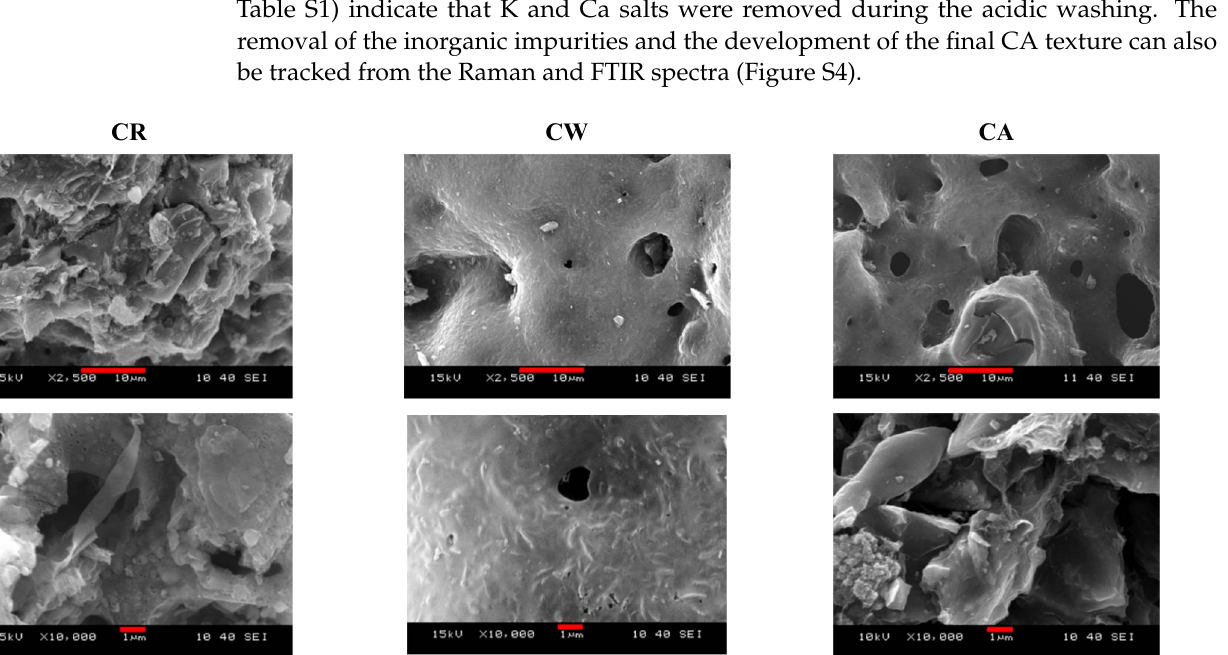
Figure 2. ( a ) Low temperature N 2 adsorption/desorption isotherms; ( b ) Pore size distribution functions were estimated by quenched solid density functional theory (QSDFT) (Kernel: N 2 at 77 K on carbon, slit/cylindrical pores, adsorption branch).